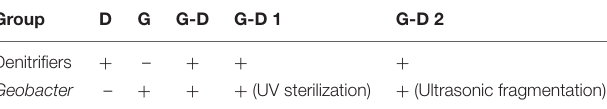
TABLE 1 | The list of experimental groups. Group D G G-D G-D 1 G-D 2